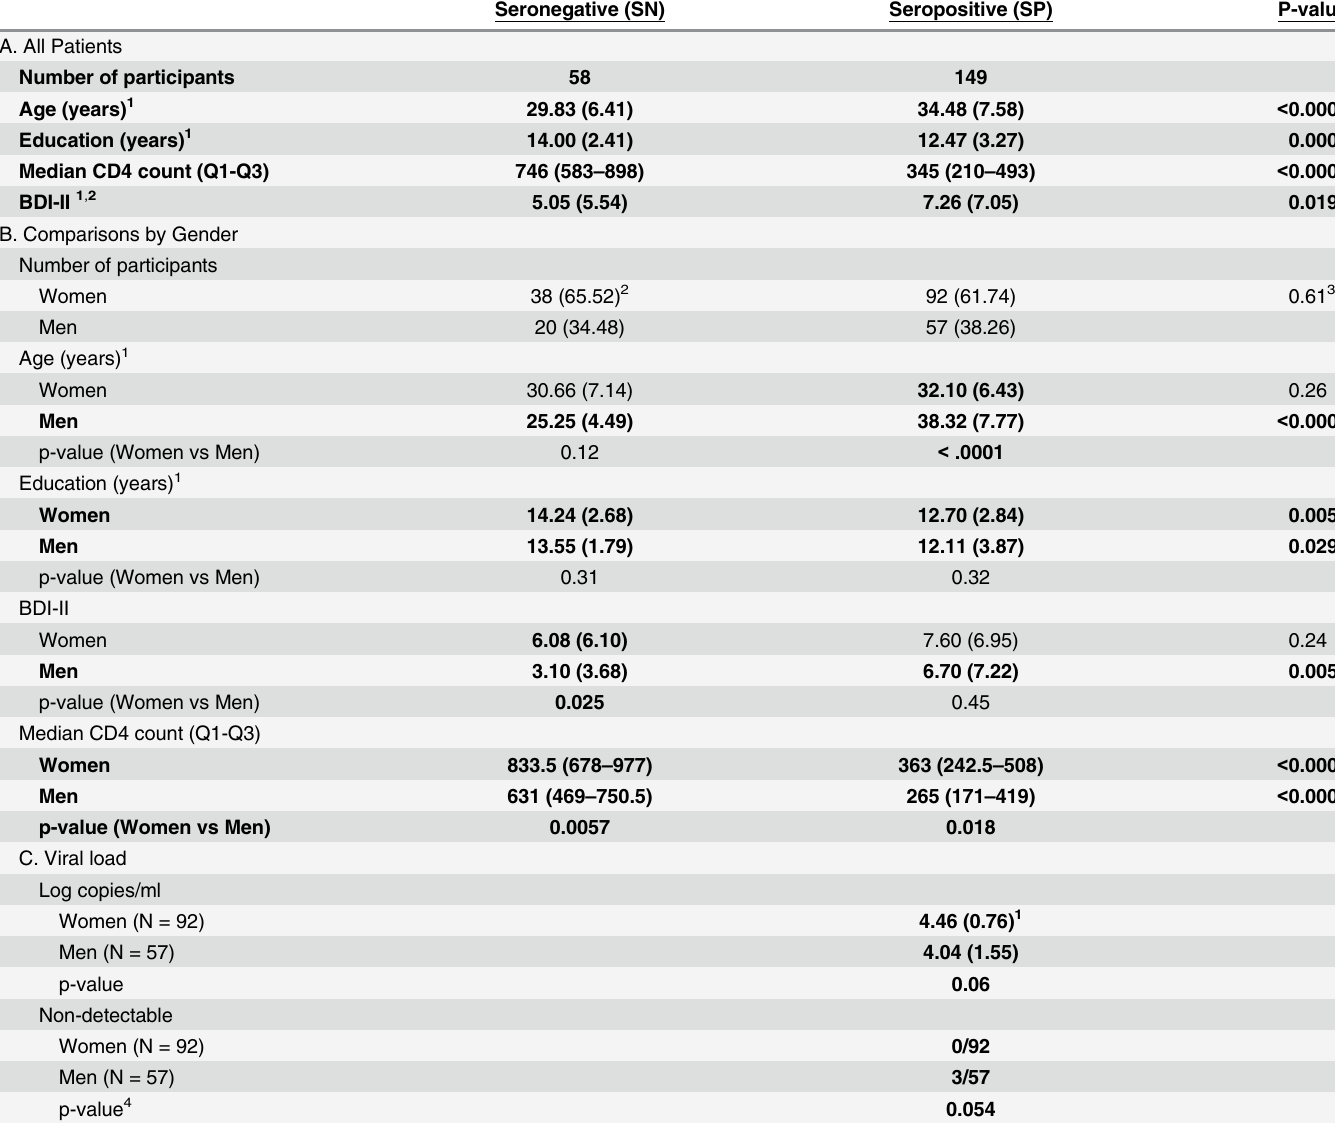
Table 1. Demographic and Clinical Characteristics for the HIV Seropositive and Seronegative